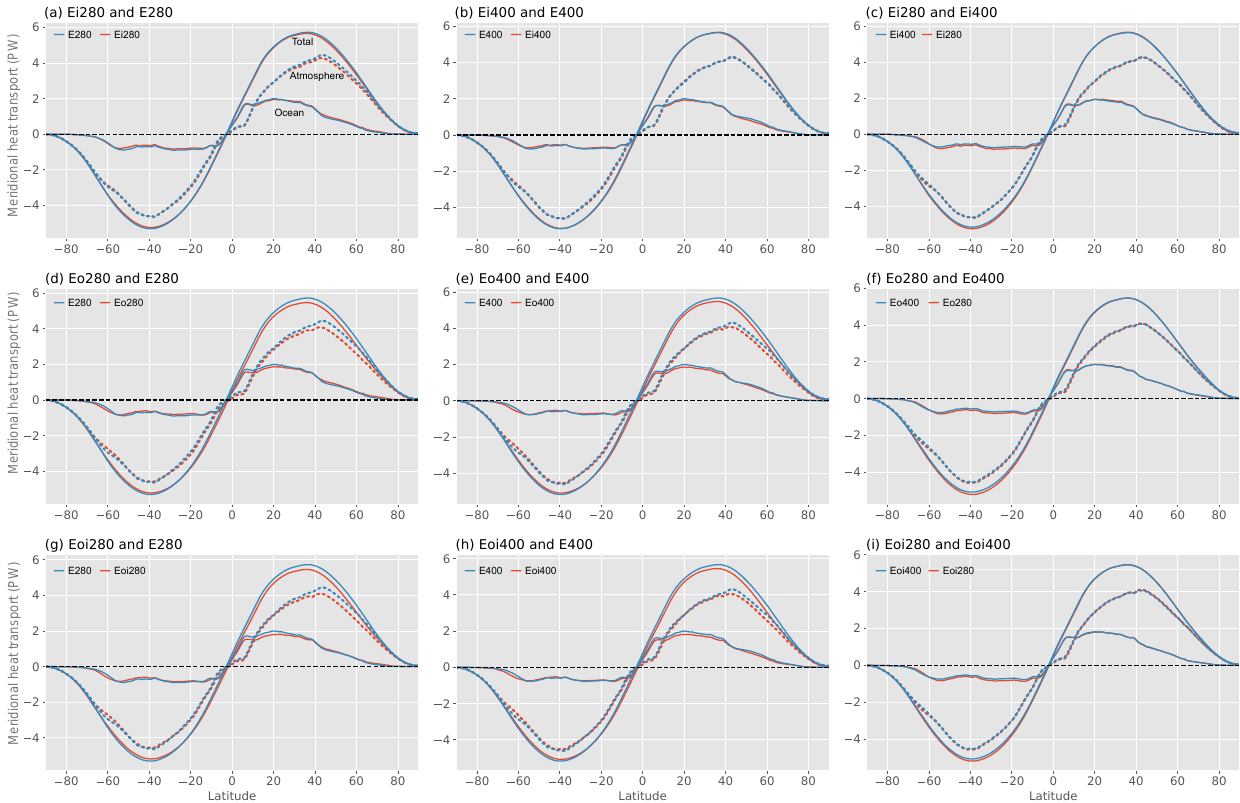
Figure 13. Various comparisons of the climatological total meridional heat transport and the individual transports by the atmosphere and the ocean. The climatology years are noted in Table